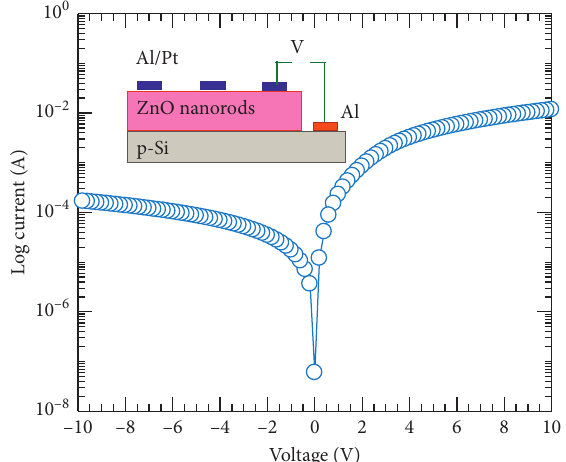
Figure 3: Current voltage characteristics of Si/ZnO